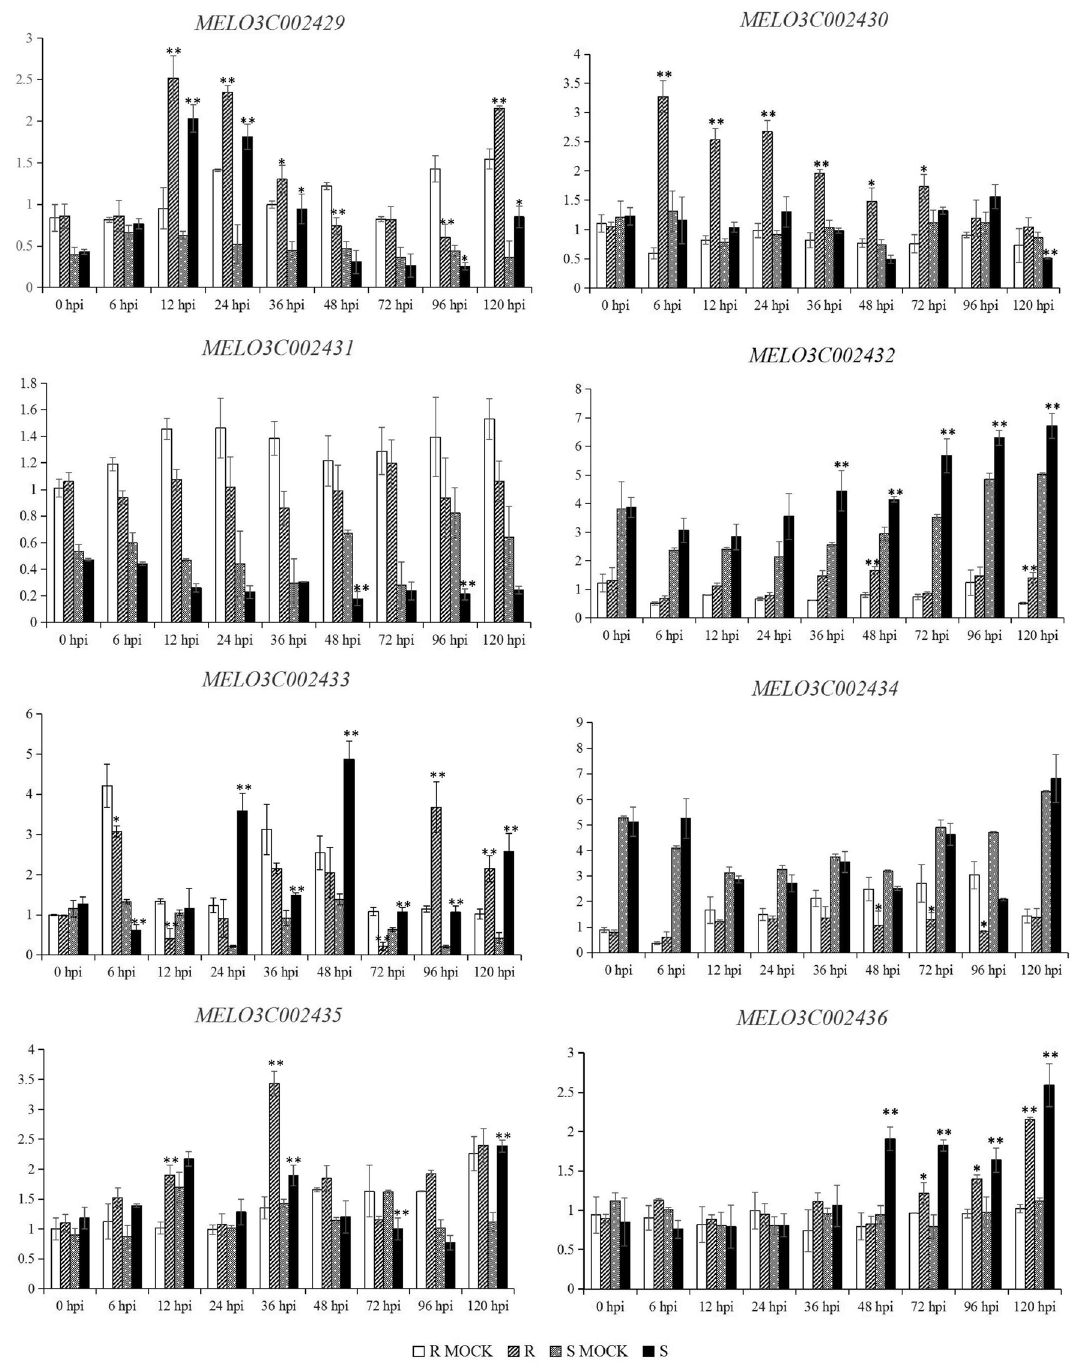
Figure 4. The expression pattern of genes in the mapping region at different time using qRT-PCR. R MOCK: ZQK9 inoculated with sterilized water. R: ZQK9 inoculated with zoospore suspension. S MOCK: E31 inoculated with sterilized water . S: E31 inoculated with zoospore suspension. Gene expression are normalized to actin. Data are displayed as the mean ± SD of three biological replicates. Significance levels are indicated as *p < 0.05 and **p <